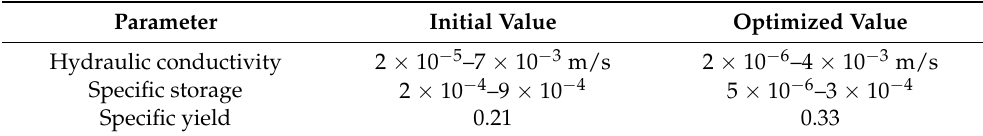
Table 1. Parameters’ initial and optimized values.